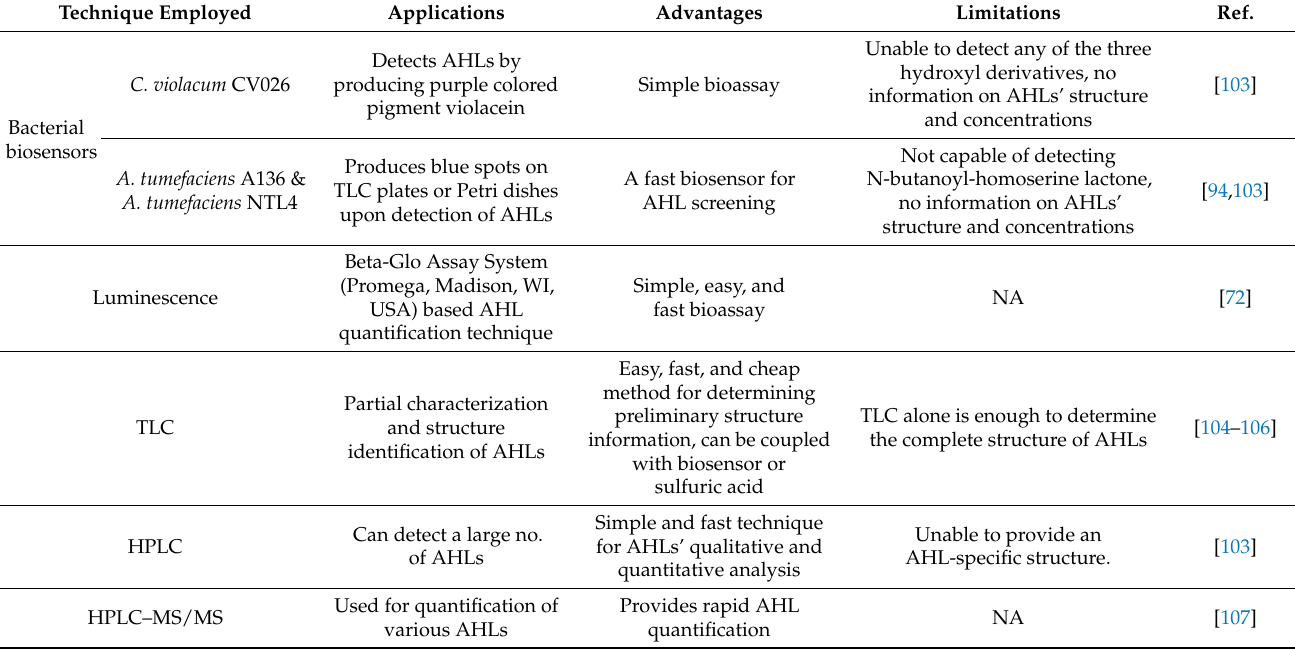
Table 2. Techniques for autoinducer detection, identification and characterization in wastewater treatment